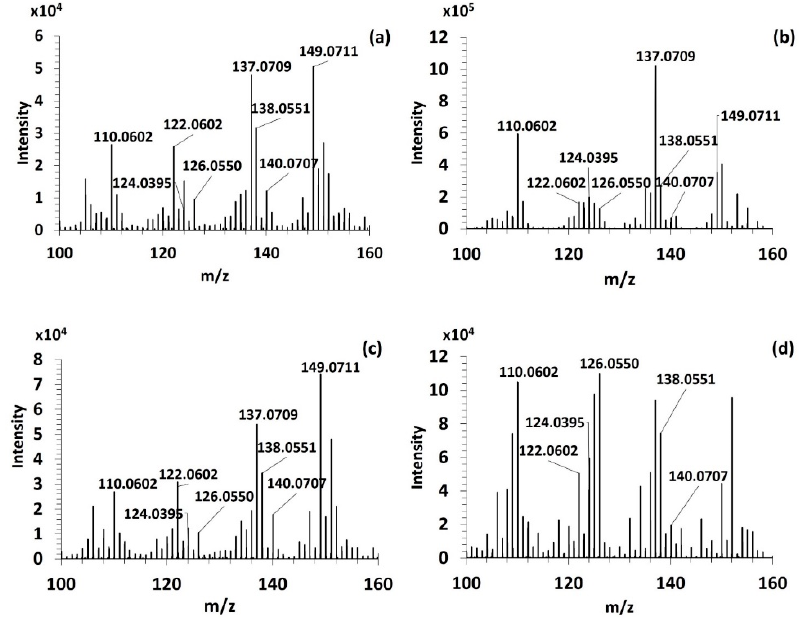
Figure 4. HCD70 MS 2 spectrum of shinorine ( a ), palythine ( b ), porphyra-334 ( c ) and Figure 4. HCD70 MS² spectrum of shinorine ( a ), palythine ( b ), porphyra-334 ( c ) and mycosporine- mycosporine-serinol ( d serinol ( d ).